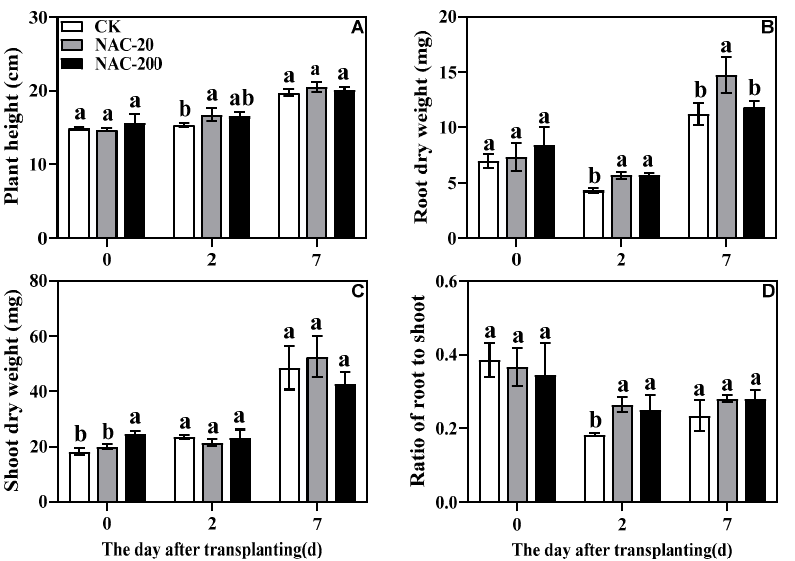
Figure 3. Effects of different concentrations of NAC on plant height ( A ), root dry weight ( B ), shoot dry weight ( C ), and ratio of root to shoot ( D ). CK, 0 µ m; NAC-20, 20 µ m; NAC-200, 200 µ m. Data are means ± SD ( n = 3). The different letters following average values indicate significant difference (Duncan, p < 0.05).